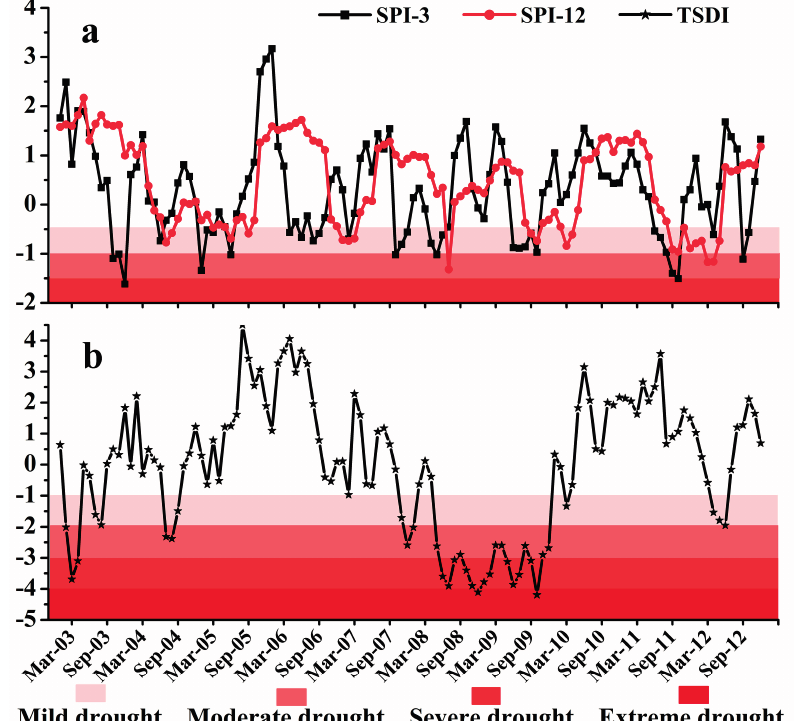
Figure 16. TSDI, SPI-3, and